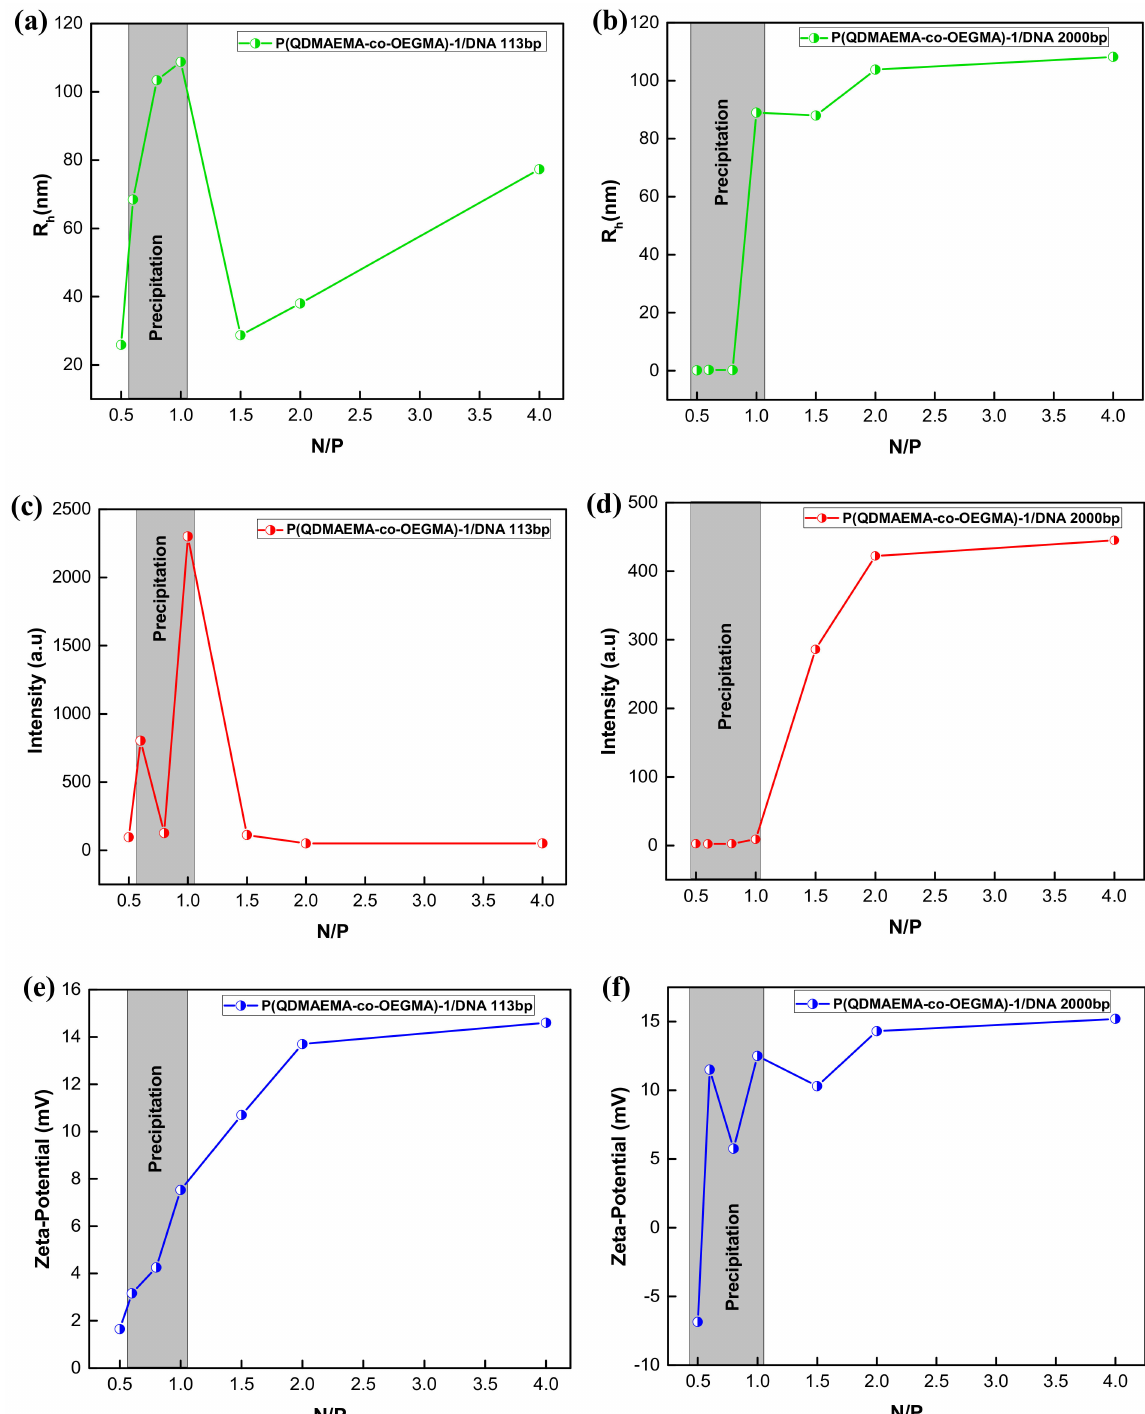
Figure 8. Variations of hydrodynamic radius (R h ) with the N/P ratio for ( a ) P(QDMAEMA-co- OEGMA)-1/DNA 113 bp and ( b ) P(QDMAEMA-co-OEGMA)-1/DNA 2000 bp polyplexes. Variations of scattered light intensity with the N/P ratio for ( c ) P(QDMAEMA-co-OEGMA)-1/DNA 113 bp and ( d ) P(QDMAEMA-co-OEGMA)-1/DNA 2000 bp polyplexes. Variations of zeta potential with the N/P ratio for ( e ) P(QDMAEMA-co-OEGMA)-1/DNA 113 bp and ( f ) P(QDMAEMA-co-OEGMA)-1/DNA 2000 bp